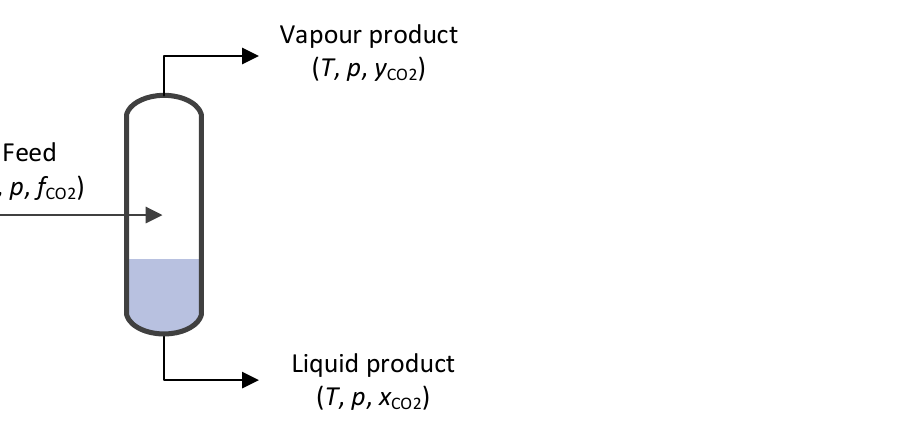
Figure 3. Phase separation of partially condensed syngas mixture. f CO2 , x CO2 and y CO2 denote mole fractions of CO 2 in the feed, liquid product and vapour product, respectively.